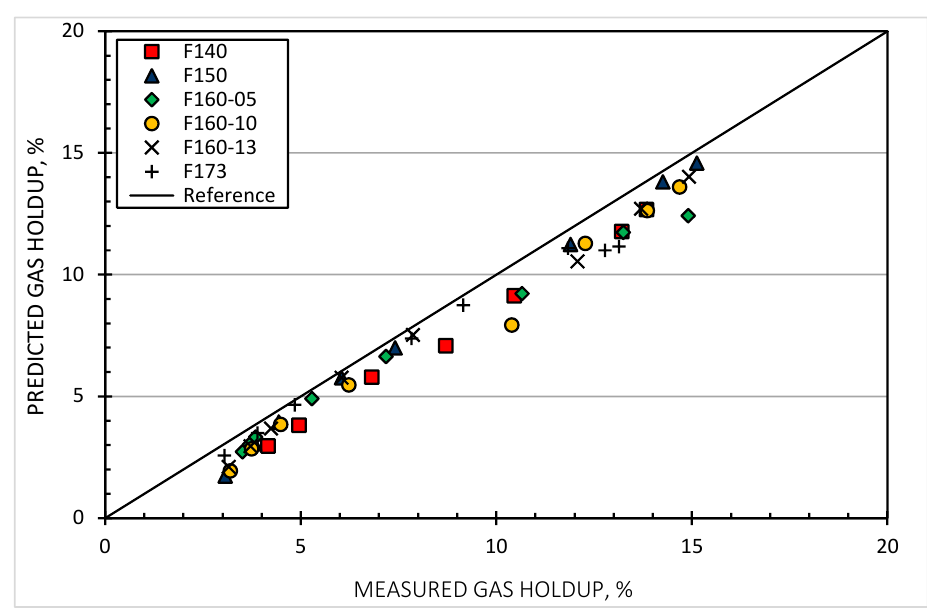
Figure 10. Predicted vs. measured gas holdup (drift-flux model).